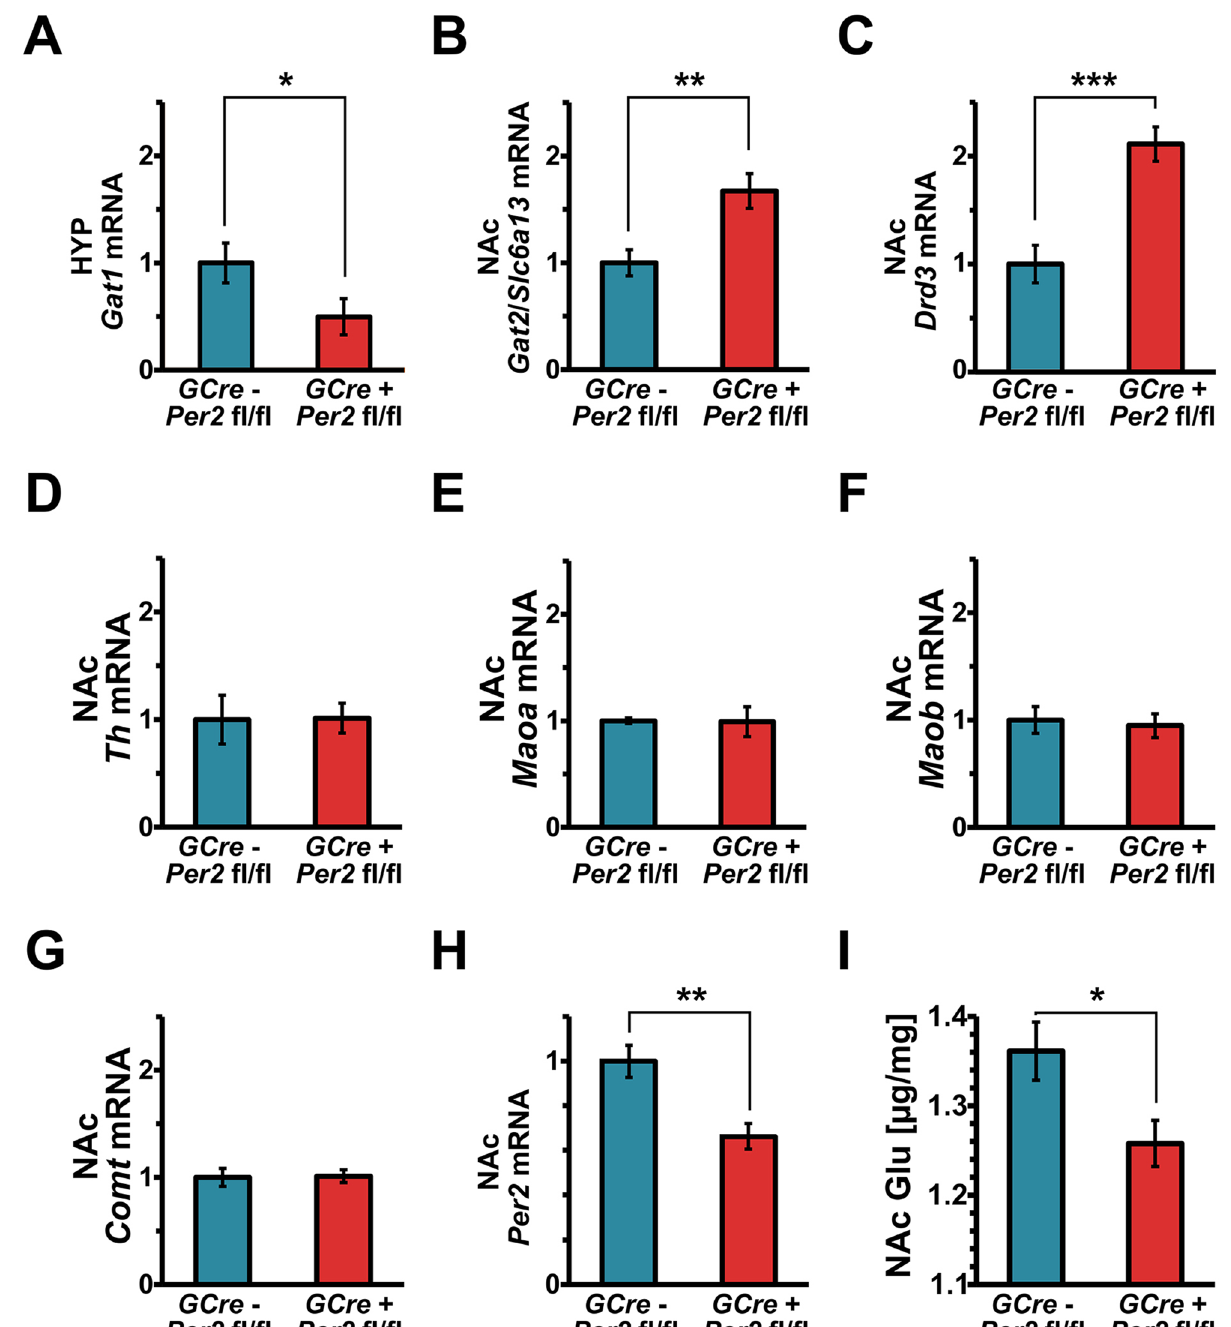
Figure 5. Molecular changes in G Per2 mice. ( A ) Expression of GABA transporter 1 ( Gat1 ) mRNA in the hypothalamus (HYP) of G Per2 ( GCre + Per2 fl/fl , red) control ( GCre - Per2 fl/fl , blue) at ZT2 (n = 3, two-tailed t-test, * P < 0.05). ( B ) Expression of GABA transporter 2 ( Gat2/Slc6a13 ) mRNA in the nucleus accumbens (NAc) of G Per2 (red) and control (blue) animals (n = 6, two-tailed t-test, ** P < 0.01). ( C ) Expression of dopamine receptor D3 ( Drd3 ) mRNA in the NAc of G Per2 (red) and control (blue) animals (n = 6, two-tailed t-test, *** P < 0.001). ( D ) Expression of tyrosine hydroxylase ( Th ) mRNA in the NAc of G Per2 (red) and control (blue) animals (n = 6, two-tailed t-test, P > 0.05). ( E ) Expression of monoamine oxidase A ( Maoa ) mRNA in the NAc of G Per2 (red) and control (blue) animals (n = 6, two-tailed t-test, P > 0.05). ( F ) Expression of Maob mRNA in the NAc of G Per2 (red) and control (blue) animals (n = 6, two-tailed t-test, P > 0.05). ( G ) Expression of catechol-O-methyltrasferase ( Comt ) mRNA in the NAc of G Per2 (red) and control (blue) animals (n = 6, two-tailed t-test, P > 0.05). ( H ) Reduction of Per2 in G Per2 mice (red) compared to controls (blue). ( I ) Amount of glutamate (Glu) in the NAc of G Per2 (red) and control (blue) animals at ZT6 (n = 5, two-tailed t-test, * P <